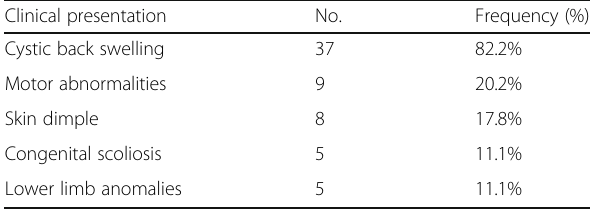
Table 1 Distribution of study population in terms of